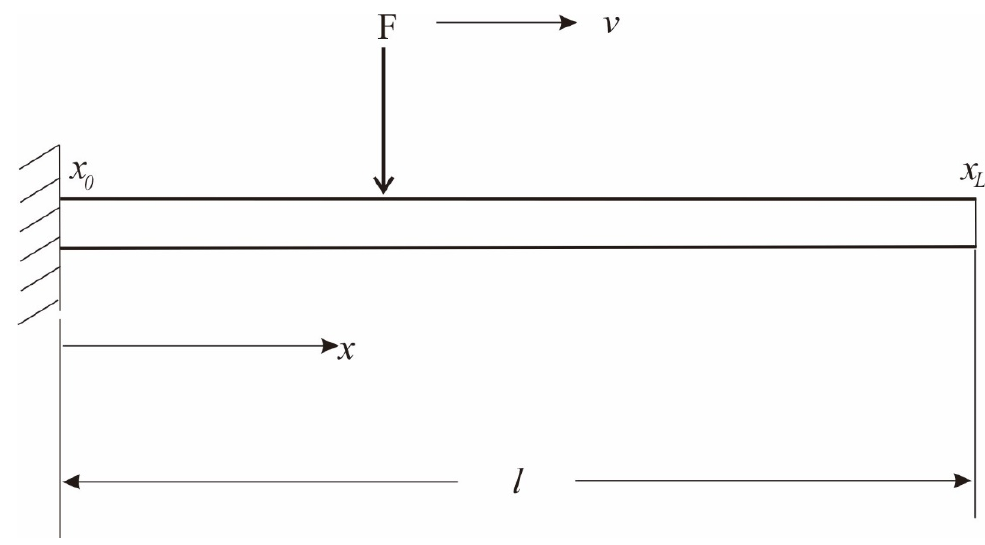
Figure 3. Cantilever beam subjected to a load.